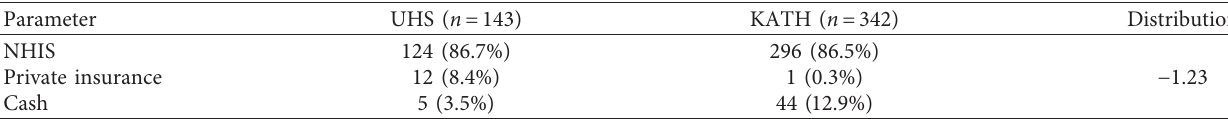
Table 3: Coverage of healthcare costs.